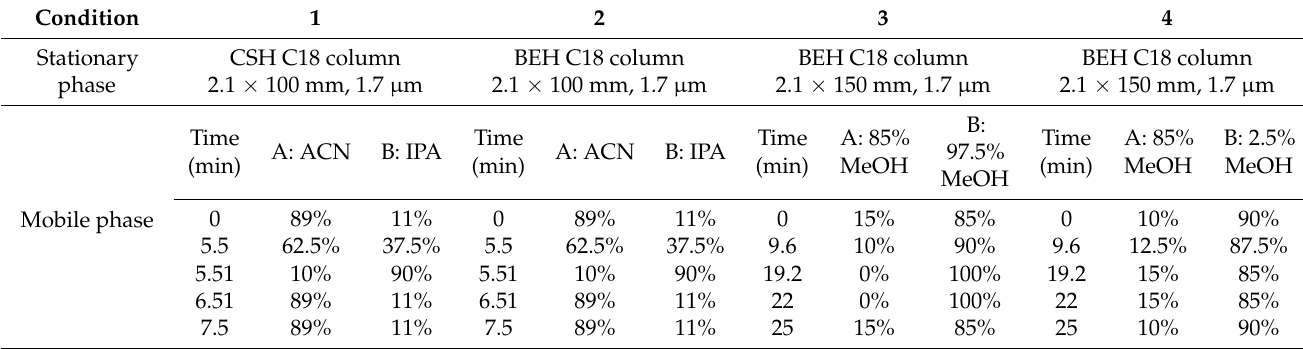
Table 1. UPLC-ELSD conditions for glycidyl ester (GE) determination.